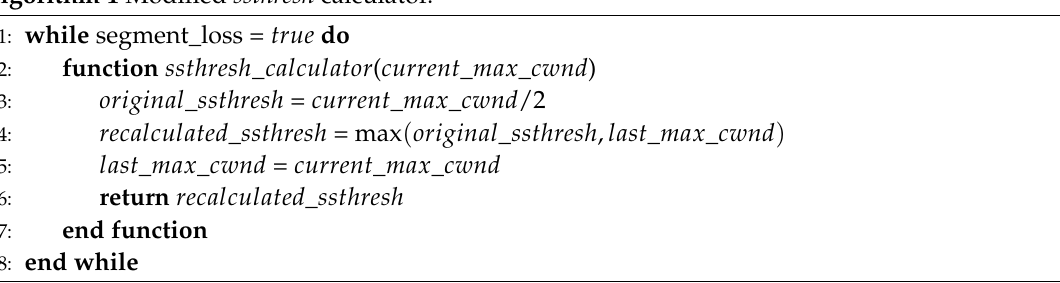
Algorithm 1 Modified ssthresh